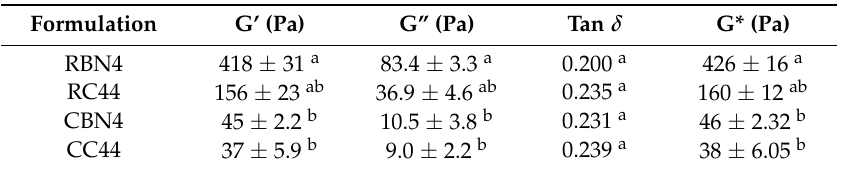
Table 5. Values (average and standard deviation) of the viscoelastic parameters, calculated from custard mechanical spectra at a frequency of 0.5 Hz at day 1.